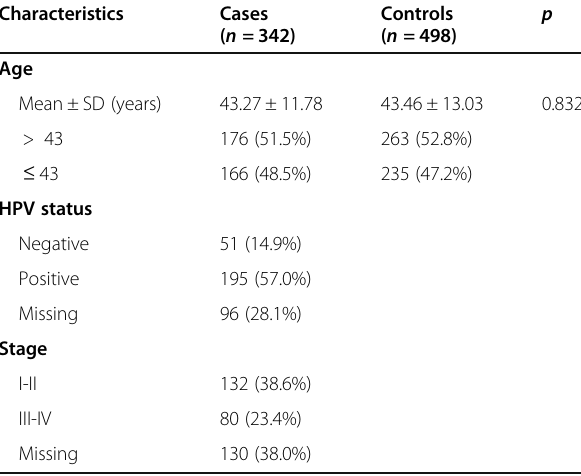
Table 1 Characteristics of patients with cervical cancer and